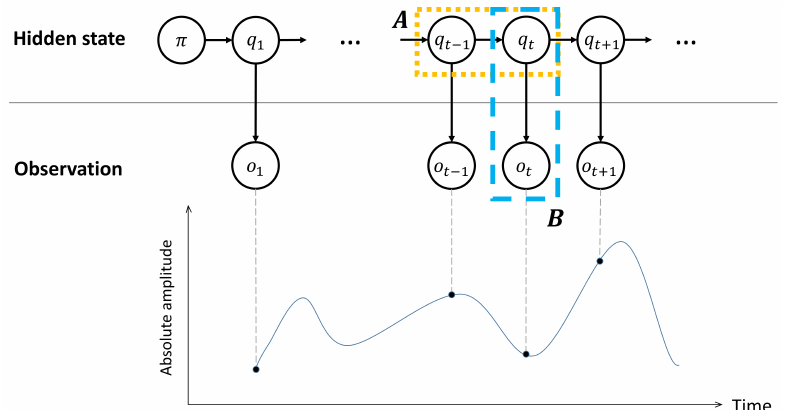
Figure 1. The structure of the HMM. The HMM explains observations o t by using three probability models. An initial state distribution π is the probability distribution over the states at the initial time. The state change (marked with dotted line) is accounted for by the first-order Markov chain, and the previous state affects the present state. An observation at a specific time appears probabilistically, which depends on the state (marked with dashed line). HMM finds the optimal probability models for observations (Baum–Welch algorithm), which are subsequently used to identify the hidden states with the observations (Viterbi